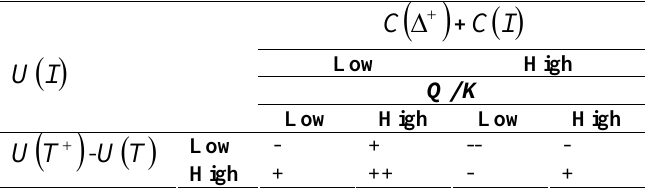
Table 1. Conceptualized determinants of the utility of information acquisition